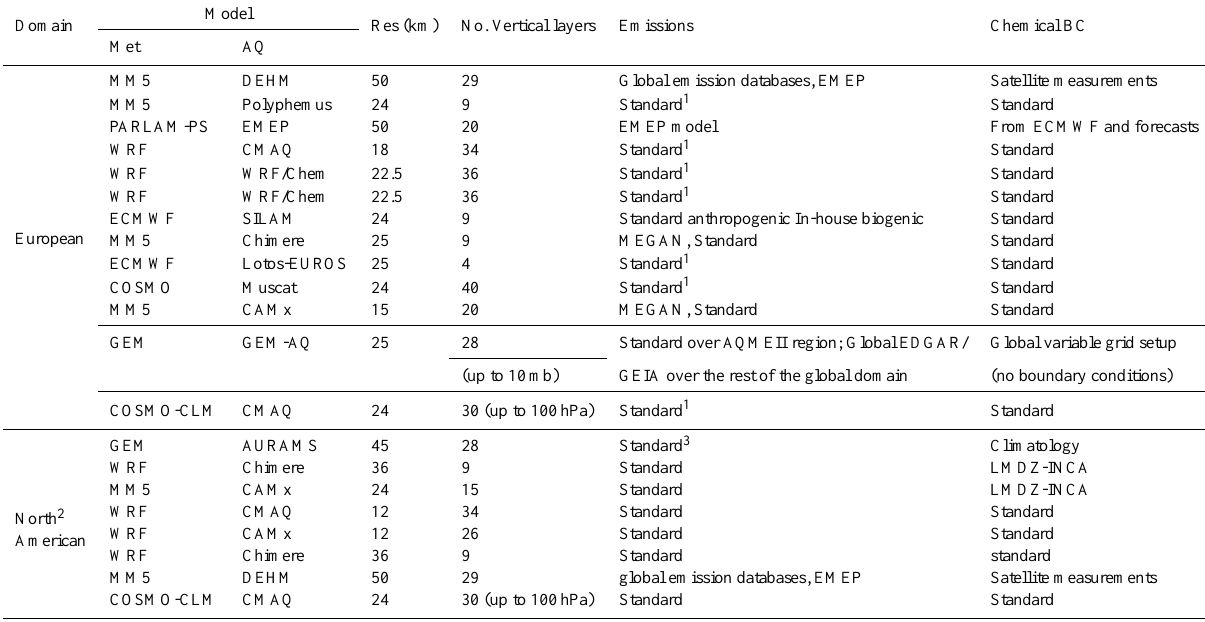
Table 3. Participating models and their features. The presented order does not correspond to the numbers presented in the figures/tables as the models are used anonymously throughout the text.